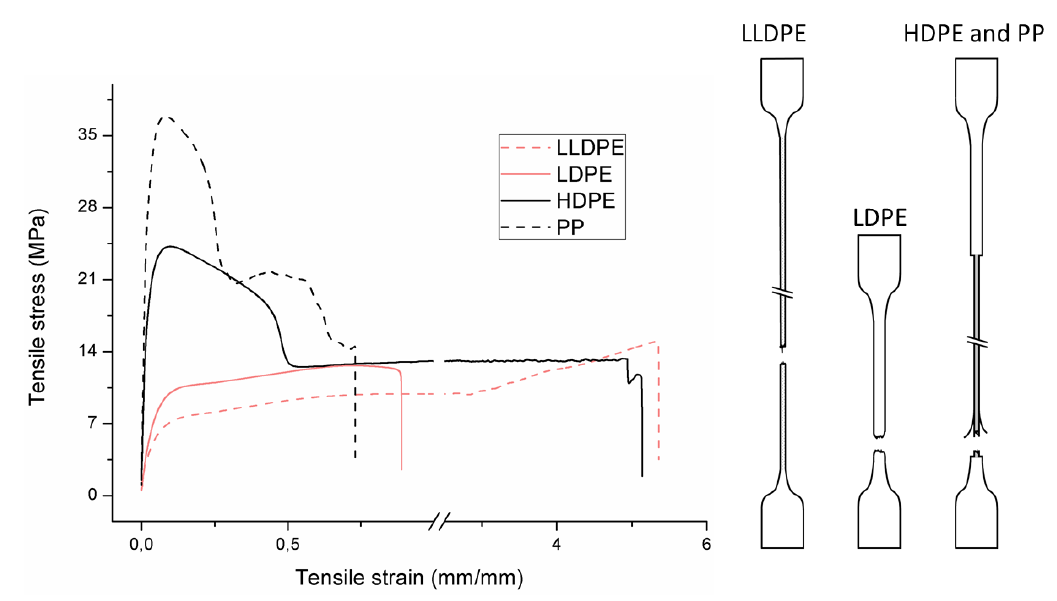
Figure 2. Stress–strain curves of the mono materials with schematic representation of the deformed samples.